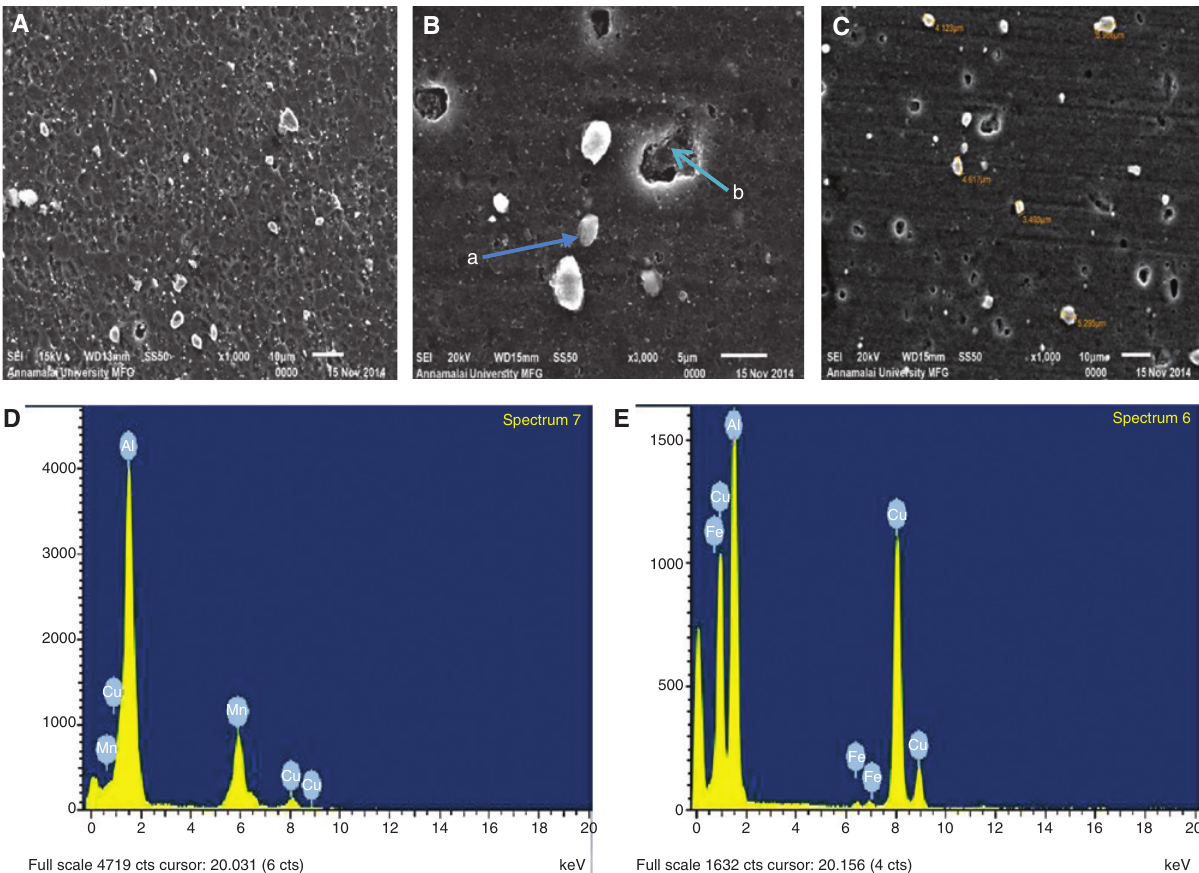
Figure 11: SEM images: (A) AW joint, (B) AA joint, (C) STA joint, (D) EDS spectrum of the a particle, (E) EDS spectrum of b particle.